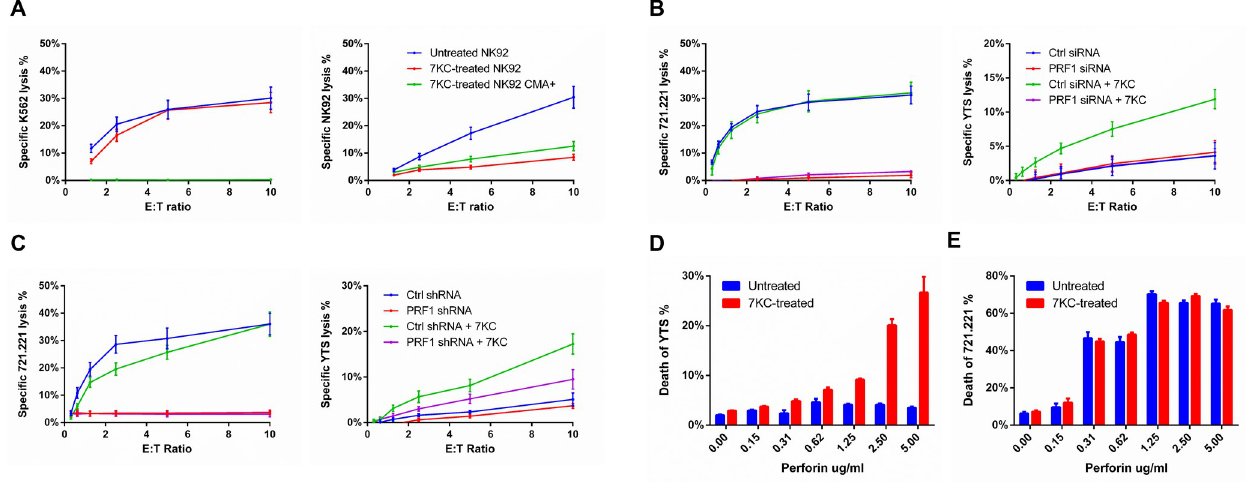
Fig 4. 7KC-induced NK cell death is perforin dependent. Cytotoxic function mediated by (A, left) and survival of (A, right) untreated or CMA-treated NK92 cells, when incubated with K562 targets, were measured using 4-h 51 Cr release assays. Cytotoxic function mediated by (B and C, left) and survival of (B and C, right) YTS cells, with or without knockdown of perforin induced by siRNA (B) or shRNA (C), were measured using 4-h 51 Cr release assay. Sensitivity of untreated or 7KC-pretreated YTS cells (D) or 721.221 (E) to free perforin were compared based on the uptake of viability dye using flow cytometry. Data represent mean values from 3 independent experiments, and error bars display ± SD (A − E). CMA, Concanamycin A; NK, natural killer; shRNA, short hairpin RNA; siRNA, small interfering RNA; 7KC, 7-ketocholesterol.